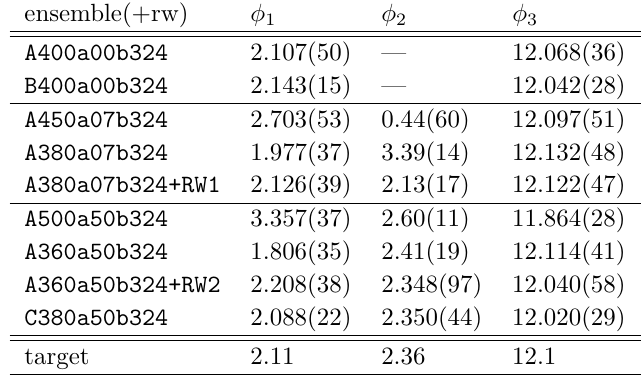
Table 6 . φ parameters for each ensemble (possibly with mass reweighting), together with the target value used to define the lines of constant physics.